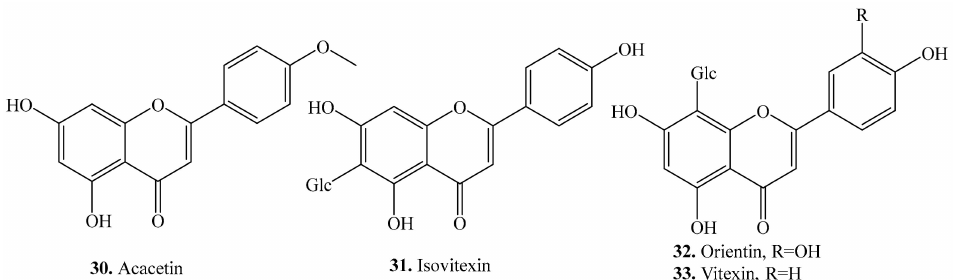
Figure 3. Structures of the flavones isolated from quinoa.